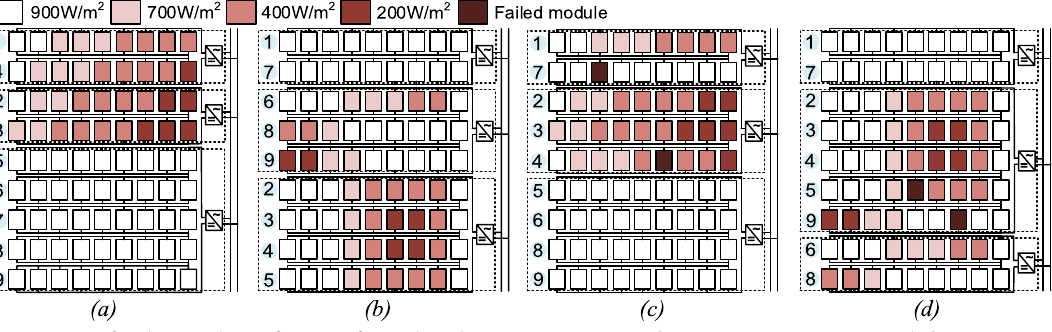
Fig. 9 Arrangement after dynamical reconfiguration for TCT-based PV array ( a ) Scenario 1; ( b ) Scenario 2; ( c ) Scenario 3; and ( d ) Scenario